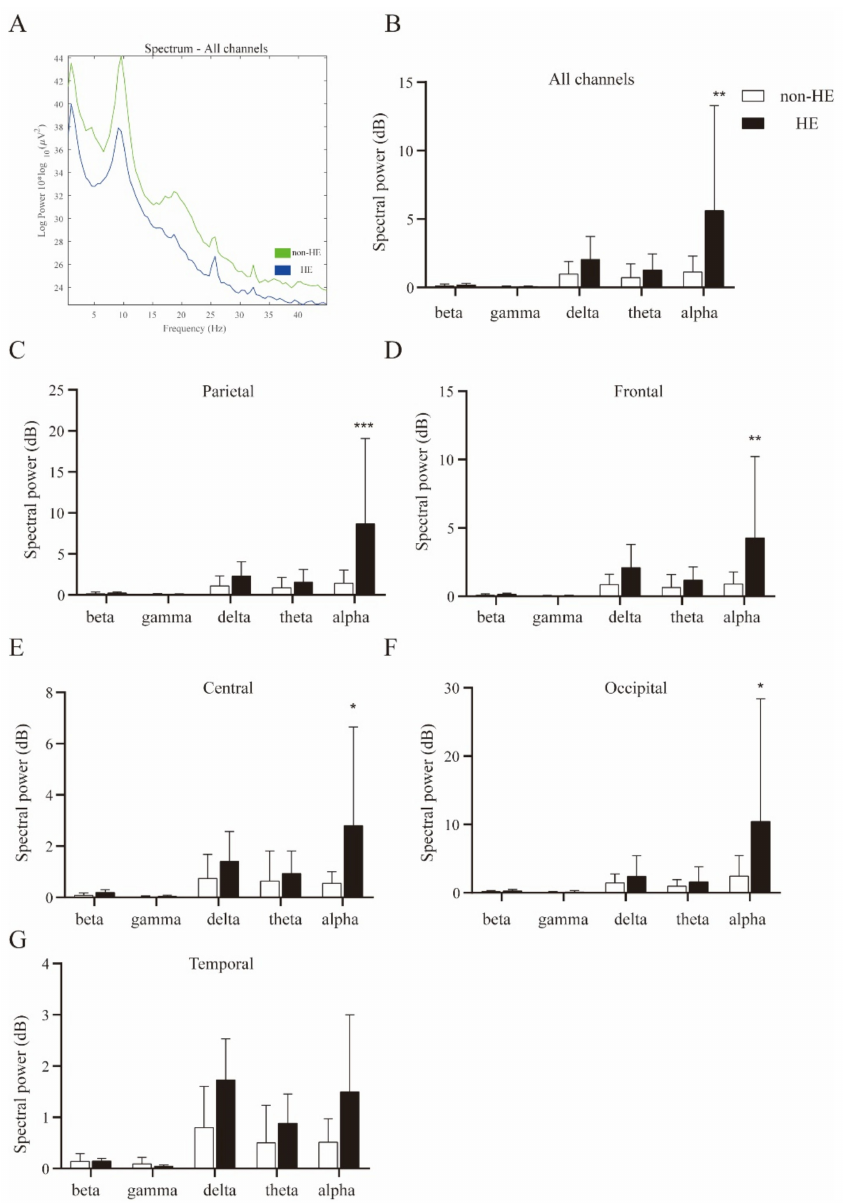
Figure 3. Reduction of alpha oscillations in the HE patients treated with PPIs. ( A ) Grand average spectral power was compared between non-HE and HE patients, ( B ) significant reduced alpha neural oscillation was associated with the HE development in cirrhosis patients under PPIs therapy. ( C – F ) Suppression of cortical alpha activity was detected in the parietal, frontal, central, and occipital, but NOT in the temporal region ( G ). A repeated-measures two-way ANOVA with post hoc Bonferroni tests. * p < 0.05, ** p < 0.01, *** p <